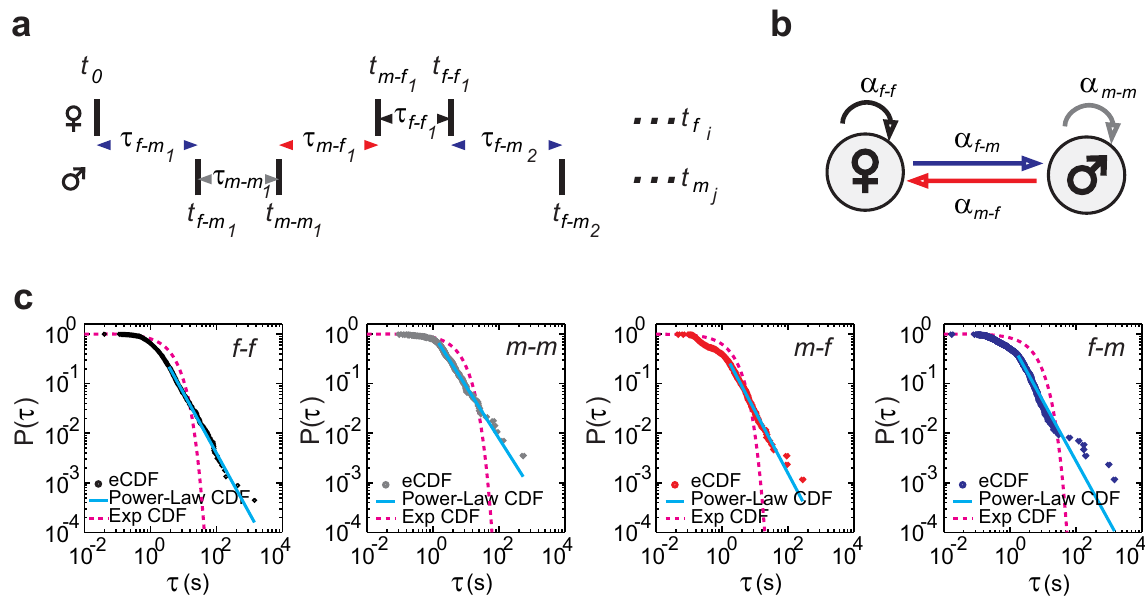
Figure 2. The self-contained (female: “ f-f ”; male:“ m-m ”) and the reactive (female: “ m-f ”; male: “ f-m ”) callings exhibit power-law dynamics. ( a ) Schematic of calling events ( t ) and inter-event intervals ( τ ). ( b ) Calling interactions are described as a mixture of self-contained (“ f-f ”; “ m-m ”) and reactive (“ m-f ”; “ f-m ”) callings of male and female zebra finches. ( c ) The empirical cumulative distribution functions (eCDF, dotted line, dark blue) of the inter-event intervals ( τ ) were plotted in a log-log scale. Estimated power-law cumulative distribution function (Power-Law CDF, solid lines, light blue) were modeled by using the maximum likelihood method 32 . Estimated exponential cumulative distribution functions (Exp CDF, dashed lines, magenta) were modeled with corresponding average inter-event intervals ( μ τ ). Data are shown from the female-male pair “a”. α : the exponent of a power-law distribution; P( τ ): the cumulative distribution of the inter-event intervals; τ (s): the inter-event intervals in seconds. (for estimated parameters, see Supplementary Table S1).